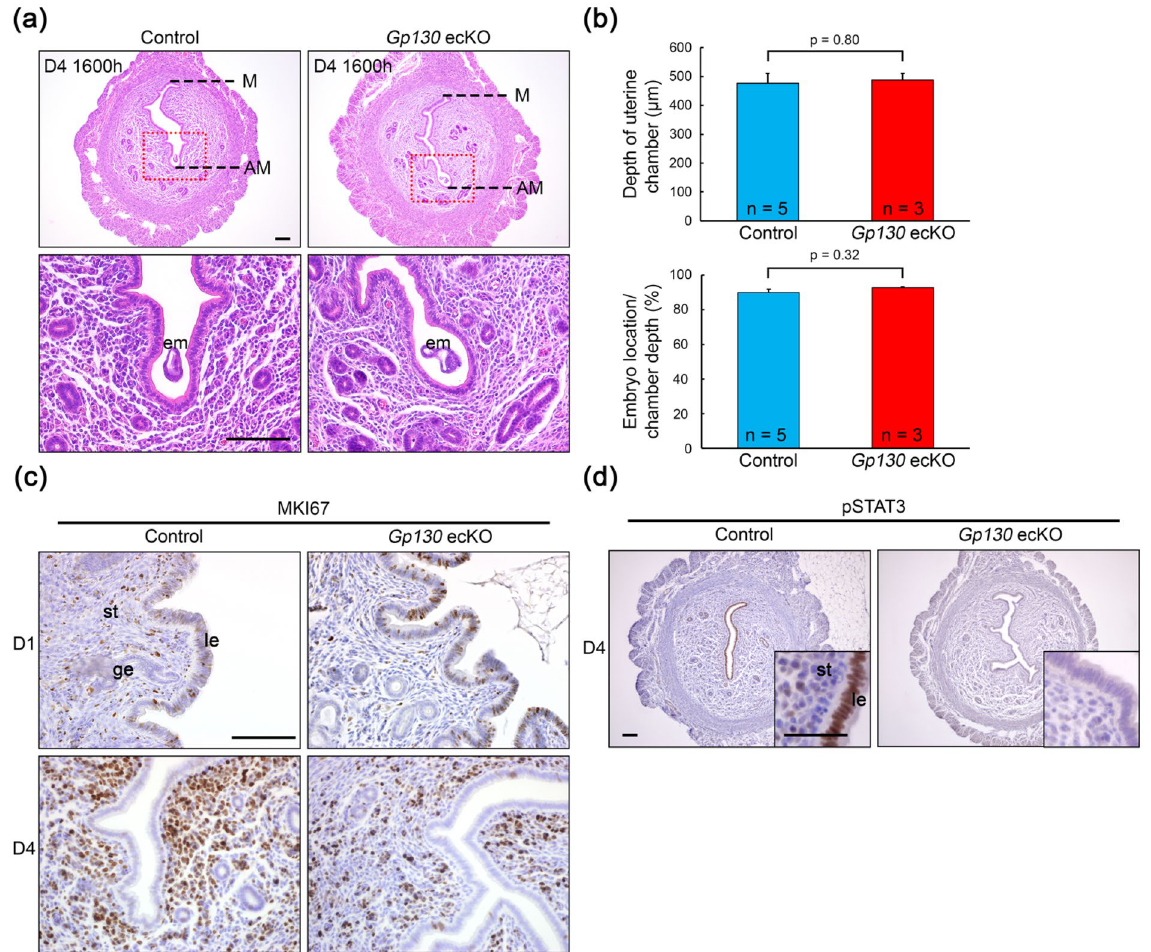
Figure 3. Histological and histochemical characterization in Gp130 ecKO uterus before embryo implantation. ( a ) Representative images of uterine cross section of pre-implantation site on D4 (1600 h) from control and Gp130 ecKO. The depth of the uterine chamber (M-AM distance) is comparable between control and Gp130 ecKO ( b , upper panel), and embryos are located in the deep antimesometrial side of the uterine chamber in both groups ( b , lower panel). ( c ) Cell proliferation status detected by immunostaining of MKI67 at D1 (1000 h) and D4 (1600 h). ( d ) Immunostaining of phosphorylated STAT3 (pSTAT3) in pre-implantation uterus (D4, 1600 h). pSTAT3 is not detectable in the uterine epithelium from Gp130 ecKO. Scale bar, 100 µm ( a , c , and d with lower magnification) and 50 µm ( d with higher magnification). le luminal epithelium, ge glandular epithelium, st stroma, em embryo, M mesometrial side, AM antimesometrial